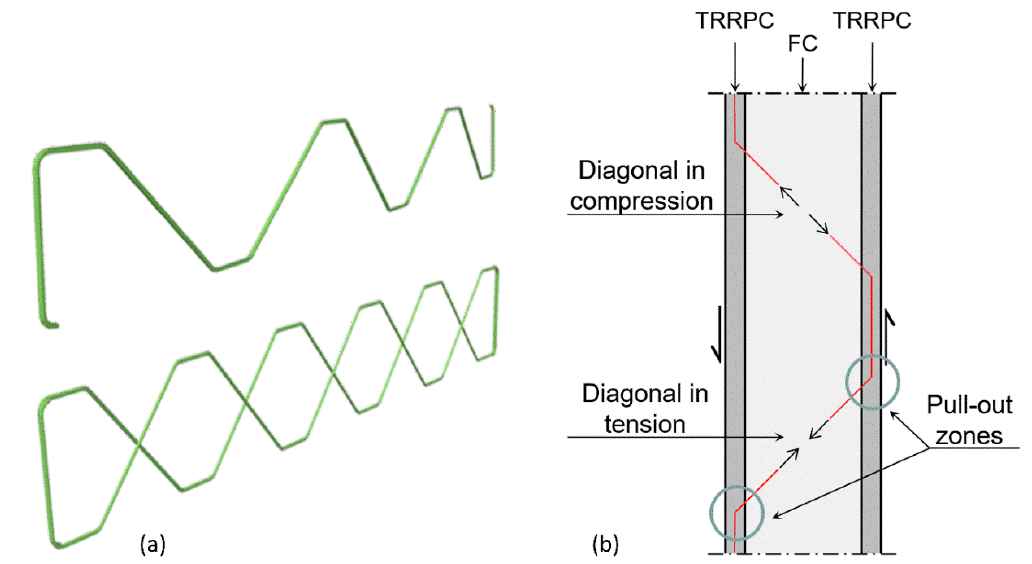
Figure 4. Photo of single (upper) and double connectors (lower) ( a ) and schematic of load transfer between the two TRRPC facings and single connector in a sandwich element ( b ).